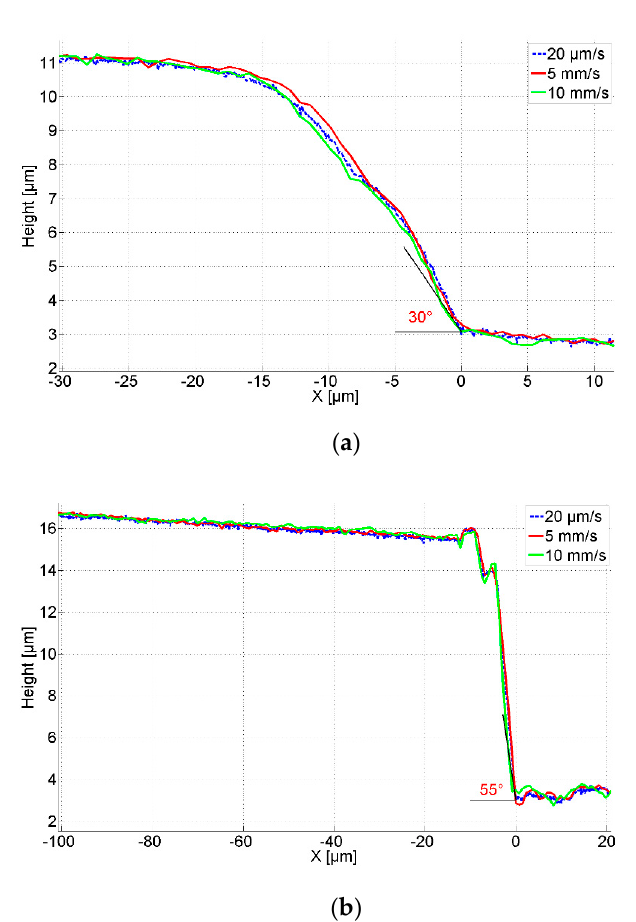
Figure 8. Measured profiles with the CAN50-2-5 microprobe with integrated silicon tip. ( a ) Measured profiles on artifact A (30° inclined sidewall) with an initial static probing force of 96 µN, at different traverse speeds; ( b ) Measured profiles on artifact B (90° inclined sidewall) with an initial static probing force of 130 µN, at different traverse speeds.